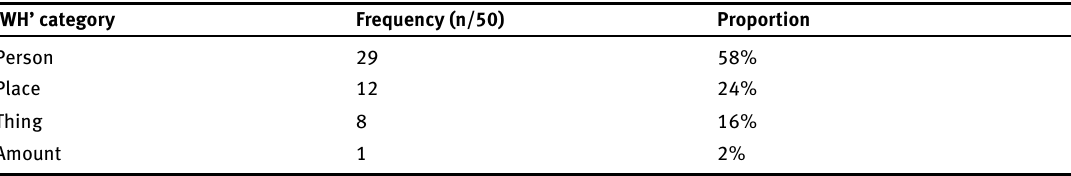
Table 4: Frequencies of request-type restricted repair initiators that feature ‘WH’ words, distinguished by ontological